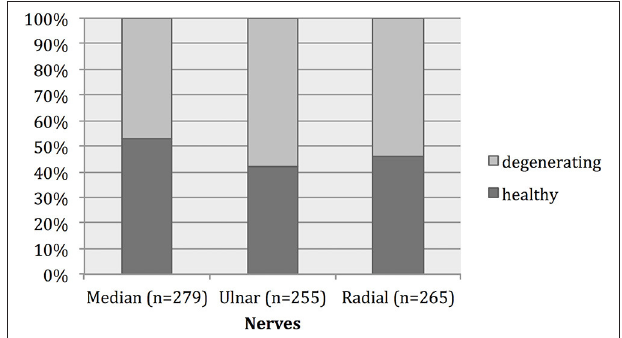
FIGURE 4 | Histogram showing the percentage of healthy and degenerative myelinated nerve fibers in our study. Forty-seven to fifty-four percent of myelinated nerve fibers showed evidence of degeneration.